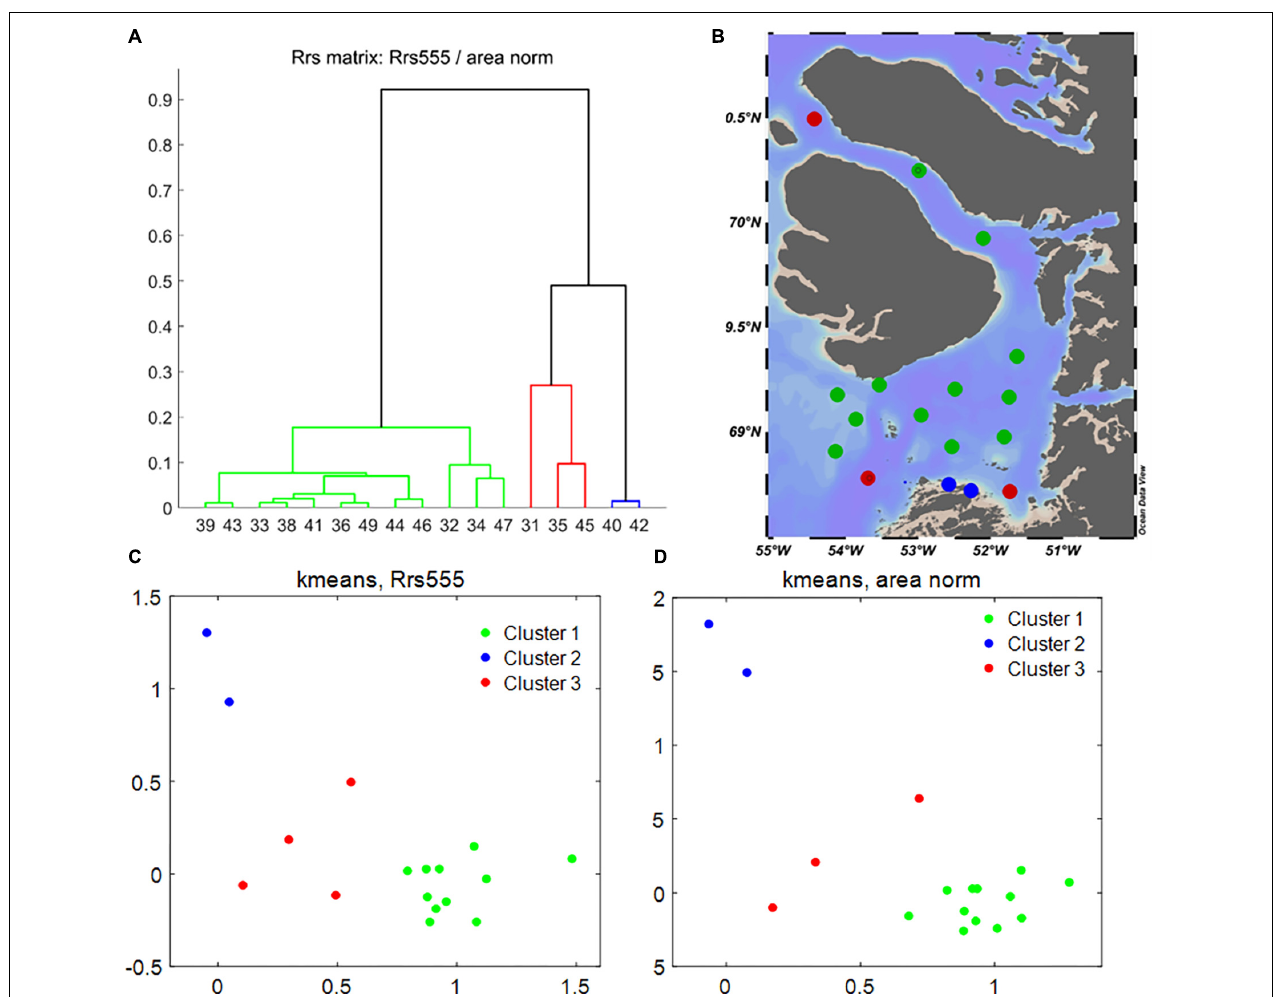
FIGURE 10 | Cluster analysis of Rrs spectra. Dendrogram (A) of hierarchical cluster analysis (cosine proximity metric) of Rrs spectra normalized following the Rrs555 and the area_norm method. (B) Geographic distribution of clusters in the Vaigat Disko Bay. Scatter plot representing clusters derived using k -means clustering (Euclidean distance) following the Rrs555 (C) and the area_norm method (D)